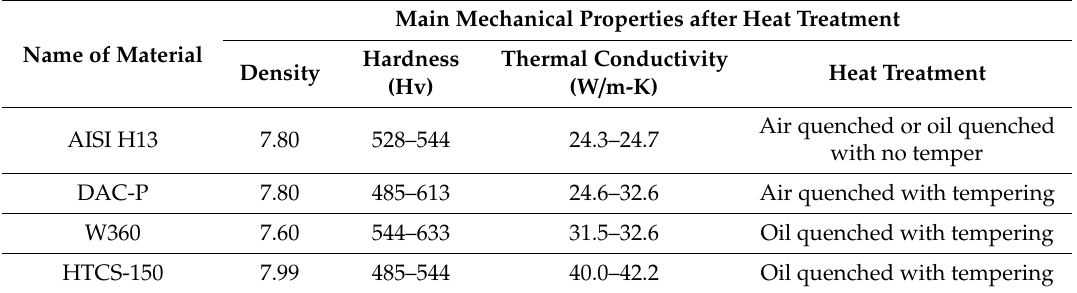
Table 2. Mechanical properties after heat treatment of commercial hot work tool